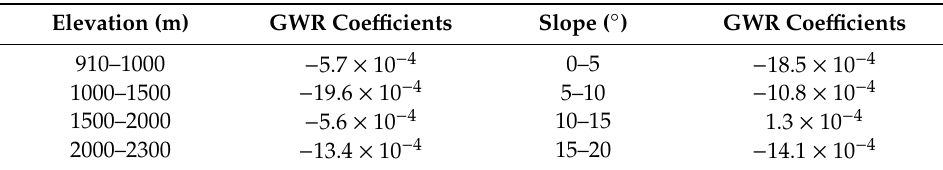
Table 4. Statistical analysis of GWR coe ffi cients for di ff erent elevation and slope.